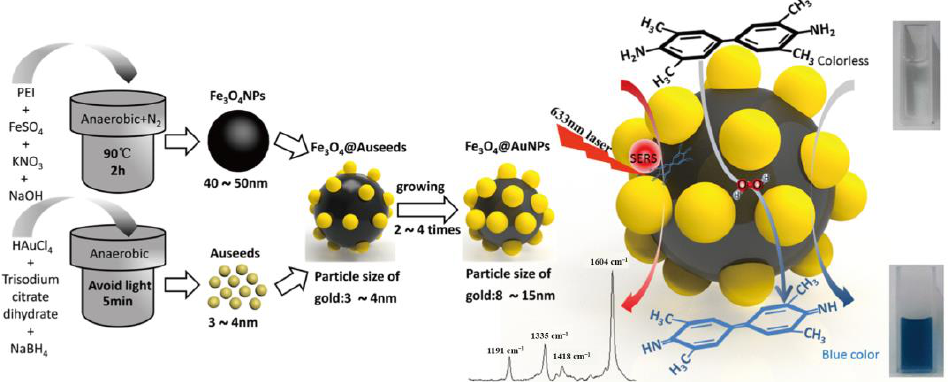
Figure 7. Schematic illustration for the synthesis of Fe 3 O 4 @AuNPs and principle of colorimetric/SERS dual-sensor of H 2 O 2 constructed via TMB-Fe 3 O 4 @AuNPs. Reprinted with permission from [95]. Copyright 2021 Elsevier